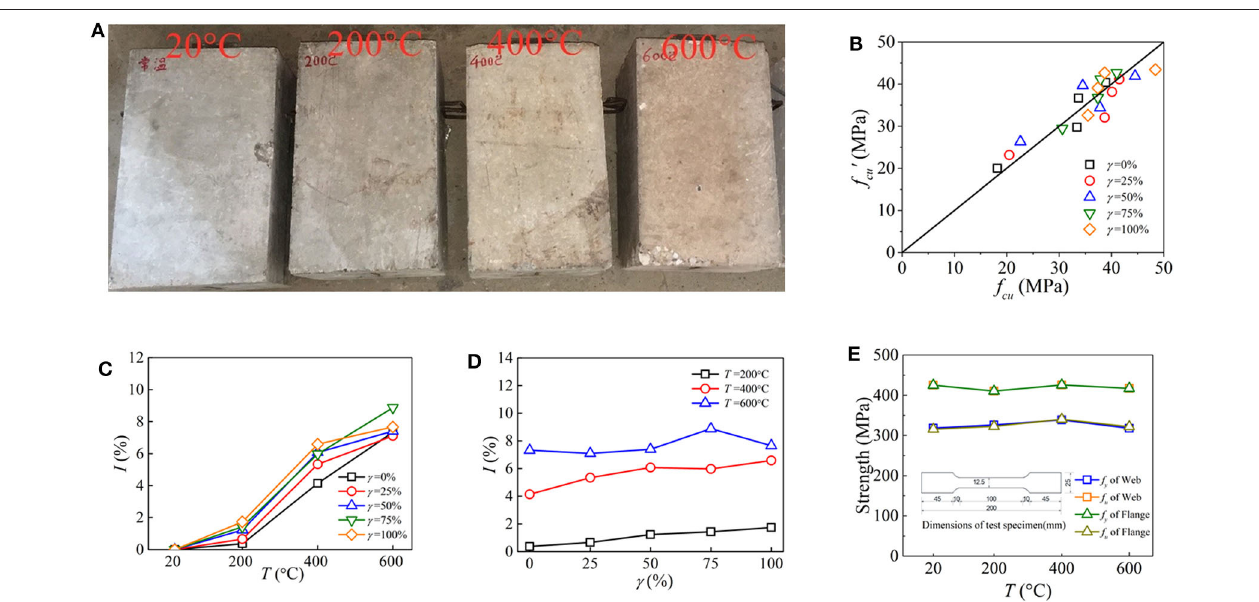
FIGURE 5 | Physical properties of specimens and their materials: (A) change in appearance of specimens; (B) comparison of test and calculation values of concrete strength; (C) measured steel strength; (D) effect of maximum temperature on mass loss ratio; (E) effect of replacement percentage on mass loss ratio.